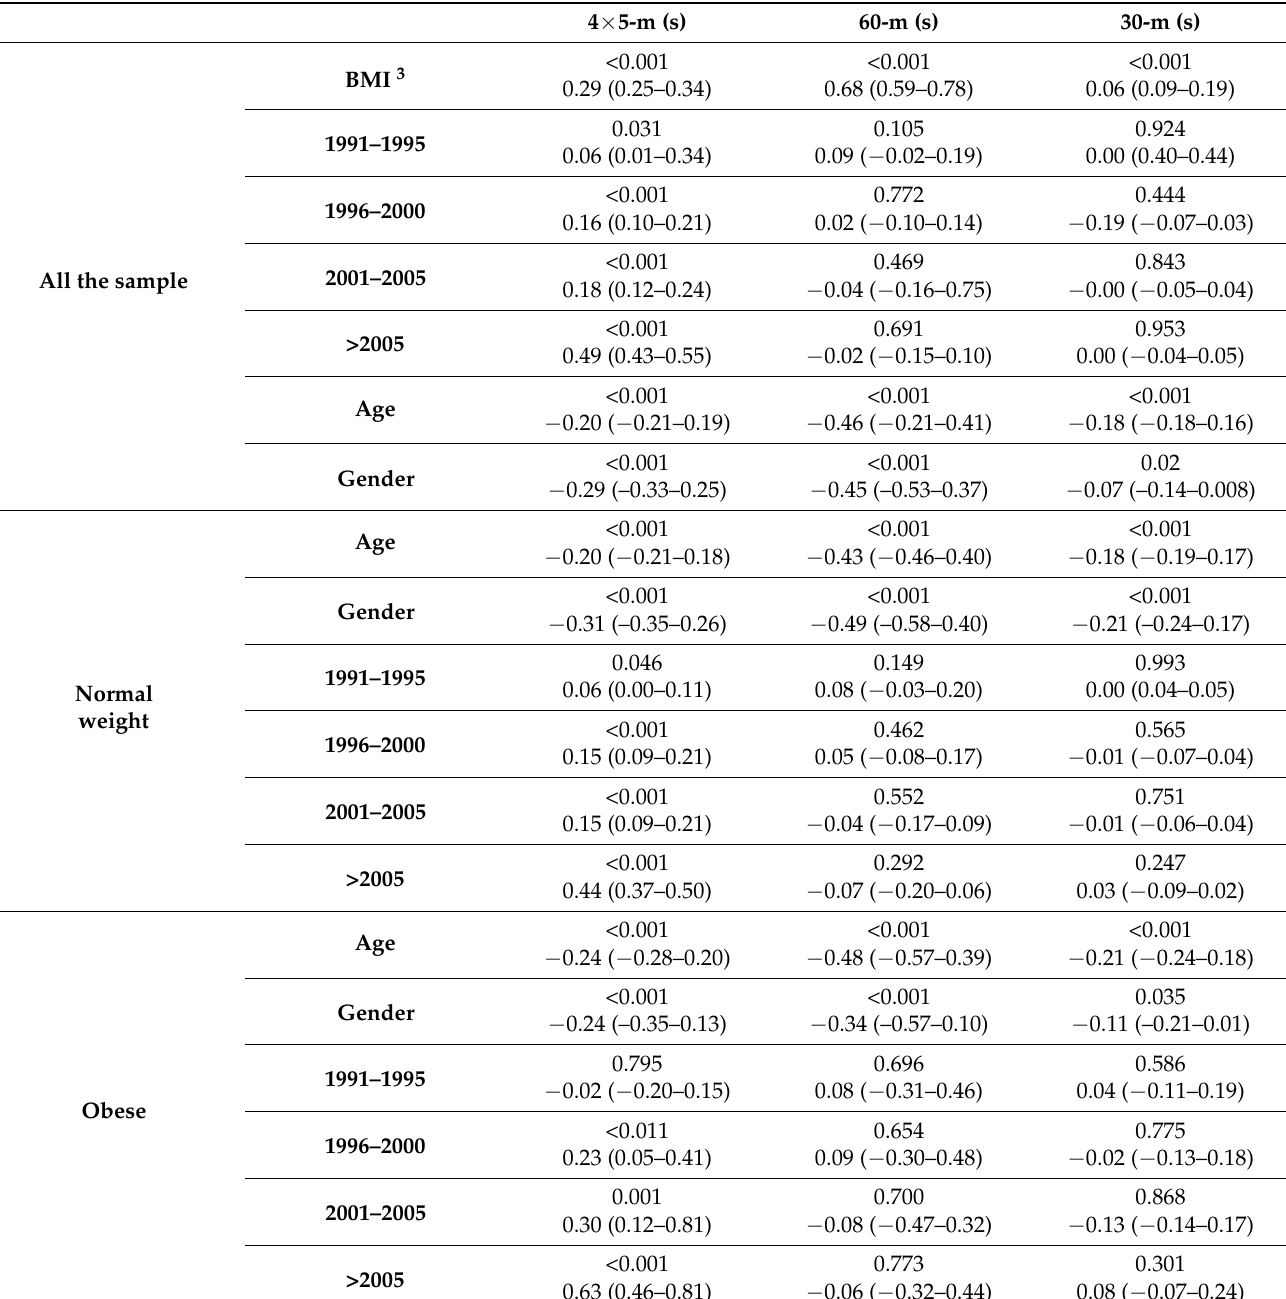
Table 5. Multivariate analysis of the whole sample.